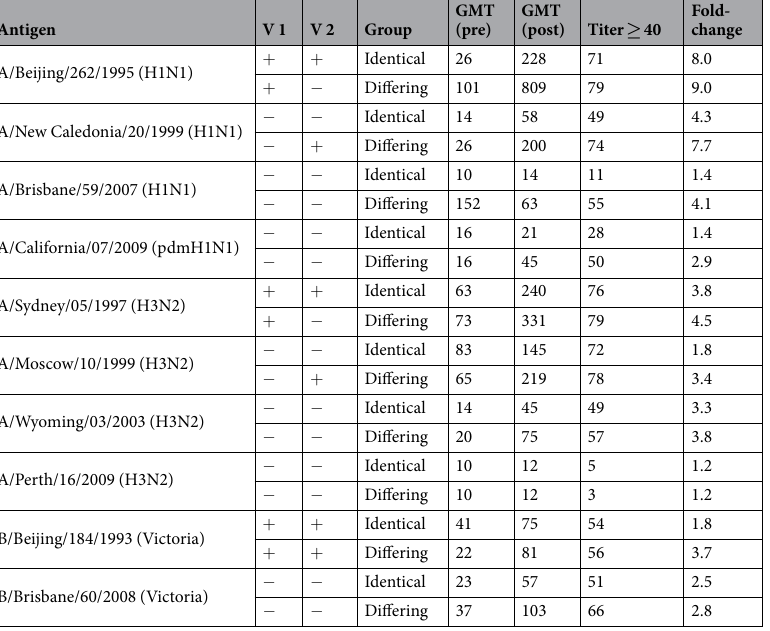
Table 3. HI Data for Drift Cohort vaccinated in 1998–2000. The names of the antigens used in the HI assay are listed in the first column. In the second and third columns + and − are used to indicate if the antigen was used in the first (V1) or second (V2) vaccination. The geometric mean titers prior to vaccination (pre) and after both vaccinations (post) are shown for each antigen for each group (Identical or Differing). The number of titers ≥ 40 is shown as a percentage. The fold-change is the average increase between the pre- and post-vaccination